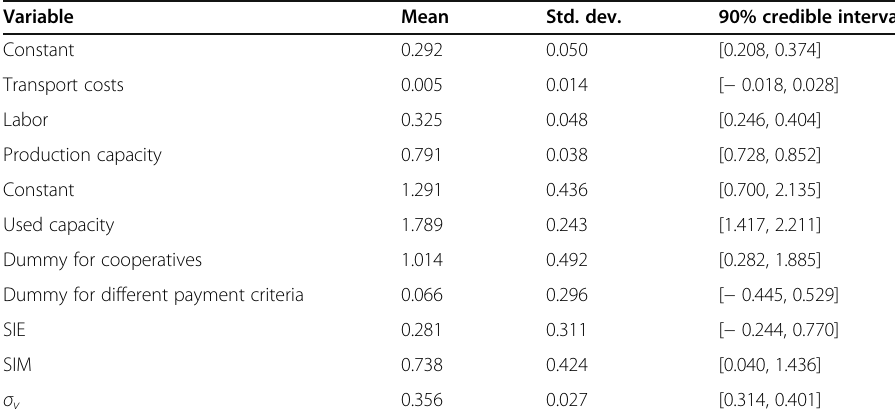
Table 3 Posterior means, standard deviations, and 90% intervals with respect to inputs, the determinants of lambda, and the variance